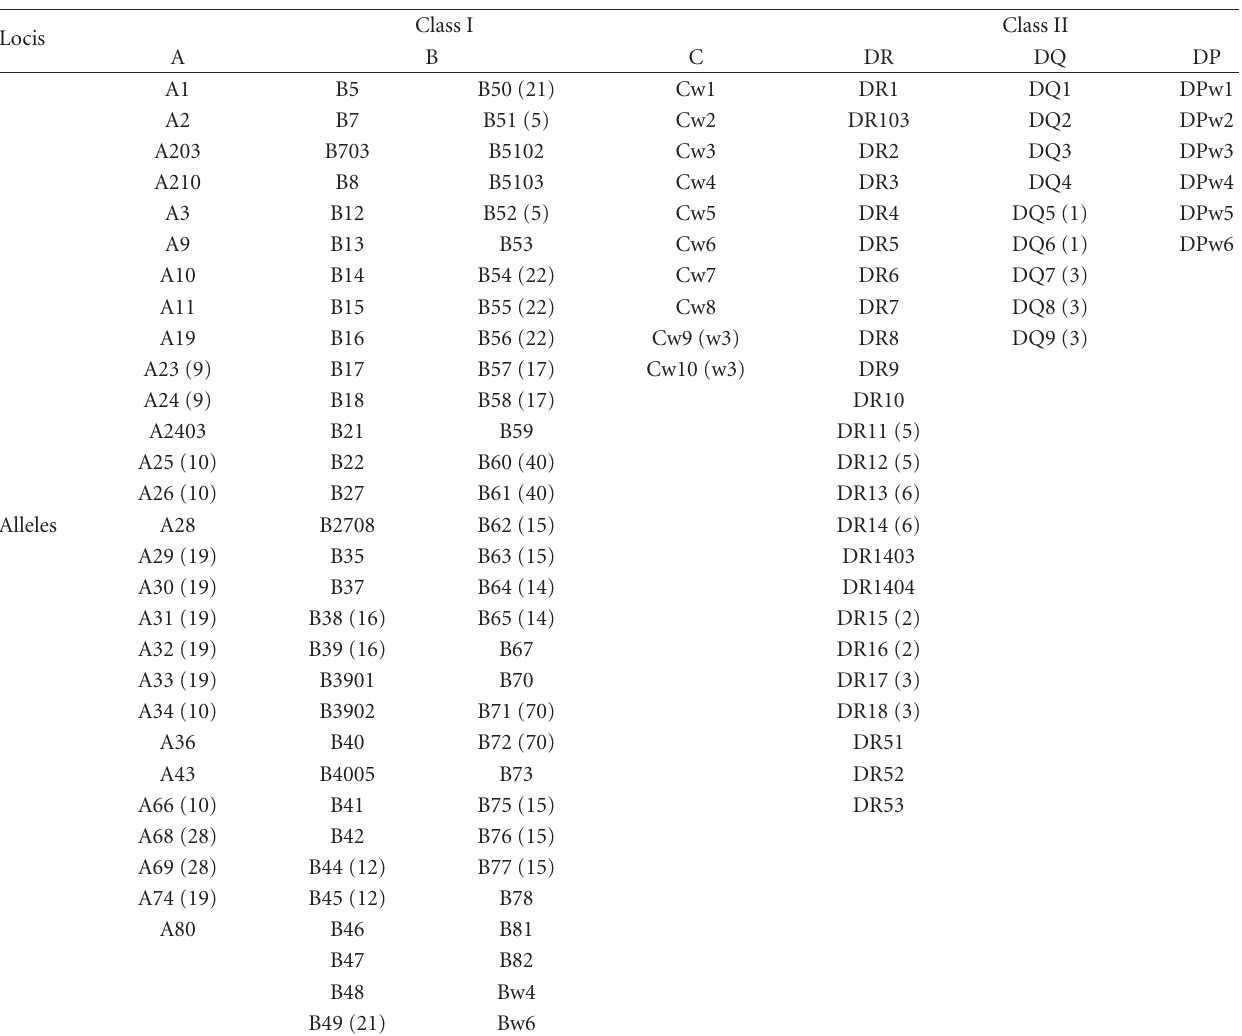
Table 1: List of all recognized serological and cellular HLA specificities.